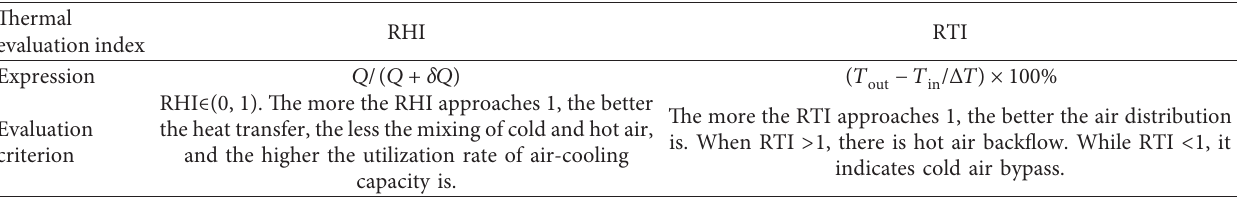
Figure 3: Temperature comparison of experimental and simulation results in cold aisles. Table 1: Description of two thermal evaluation indexes.